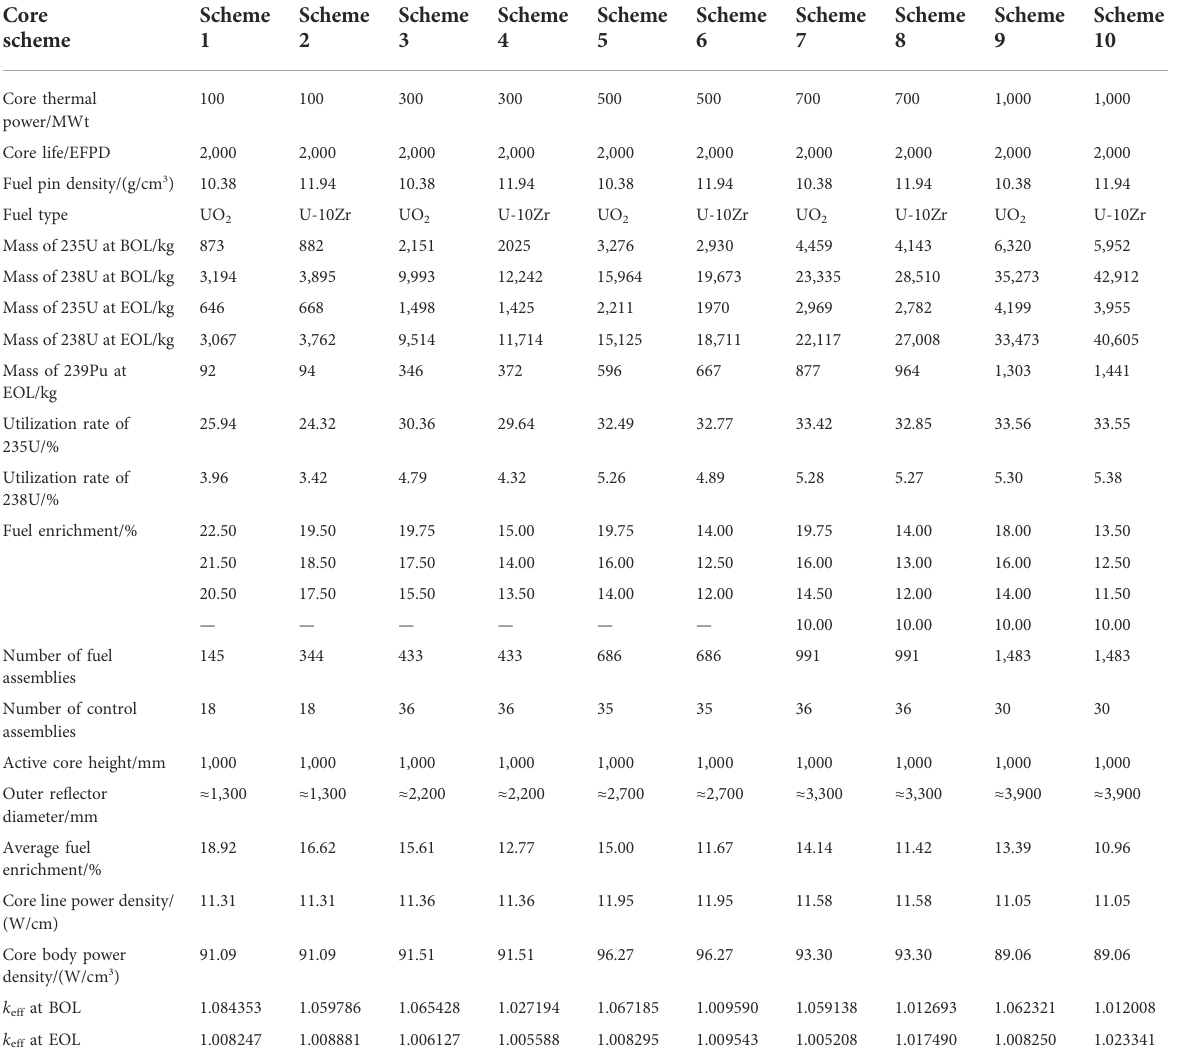
TABLE 3 Design parameters of all the